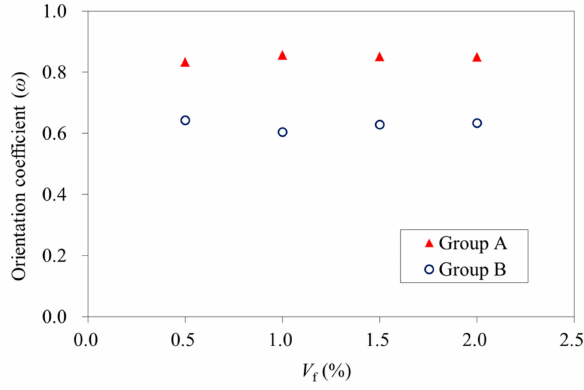
Figure 9. Fiber orientation coefficients of specimens having different fiber volume fractions.